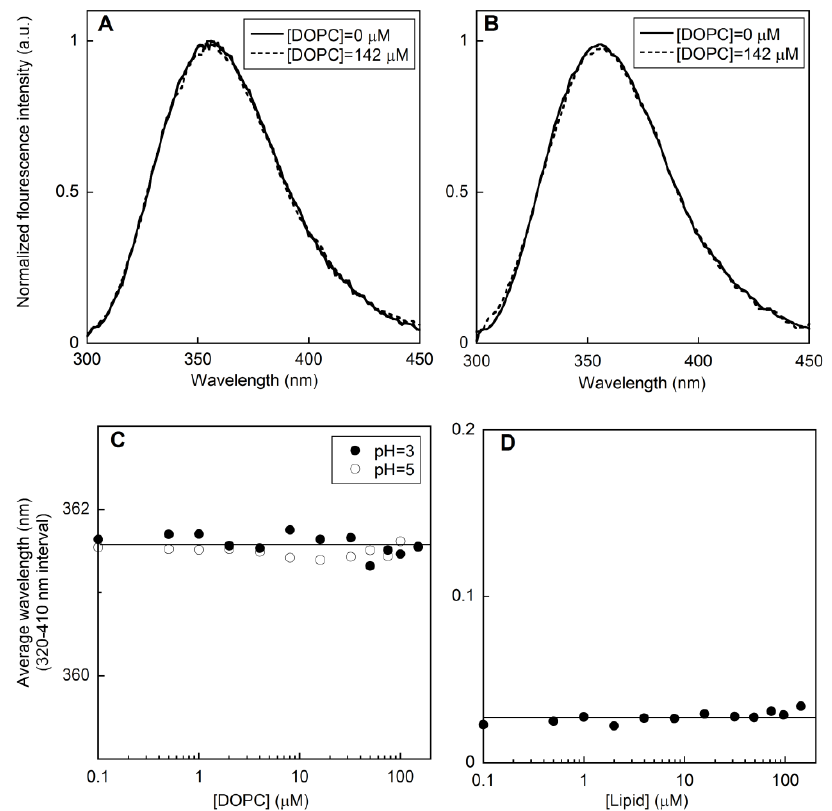
Figure 1. Normalized fluorescence intensity of 0.69 μM type I’ β -turn peptide structure CSF114 against wavelength in the absence (solid curve) and in the presence (dashed curve) of 142 μM DOPC at pH 3 (A) and pH 5 (B). Average wavelength against DOPC concentration at pH 3 and 5 (C). Fluorescence anisotropy of 2.0 μM CSF114 against lipid concentration at pH 3